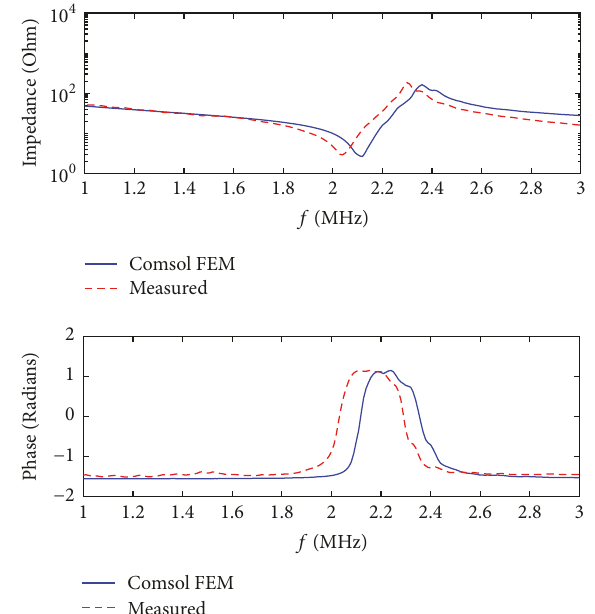
Figure 15: Equivalent input impedance of the channel through a cylindrical metal